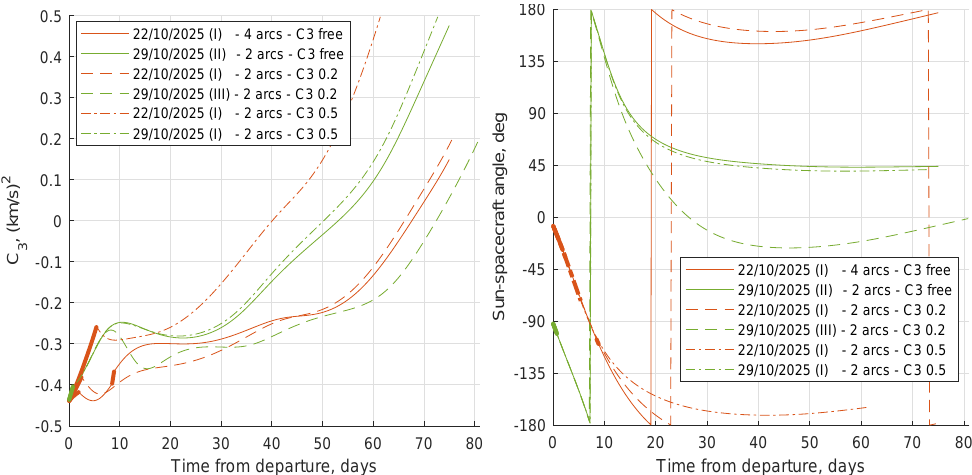
Figure 20. Spacecraft energy over time ( left ) and Sun–spacecraft relative angle ( right ) for selected EML2 escape dates—comparison between free and fixed final C 3